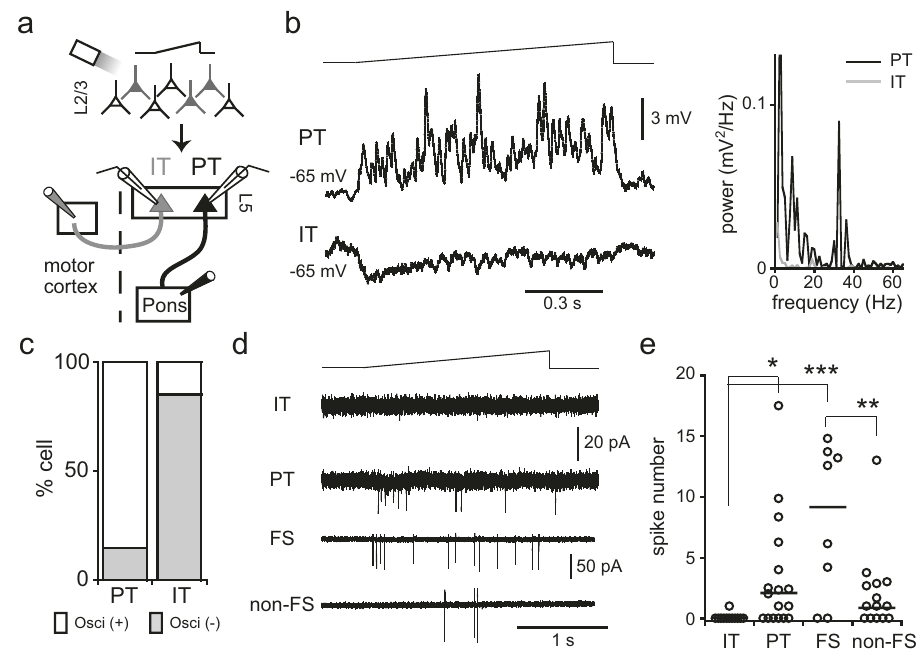
Fig. 3 Responses to L2/3 PC photostimulation in L5 cell subtypes. a Identi fi cation of L5 PC subtypes by retrograde fl uorescent tracer injections to contralateral cortex and ipsilateral pontine nuclei. b Dual recordings from identi fi ed PT and IT cells. Ramp-shaped light stimulation to L2/3 induced oscillations in PT cells, but not IT cells. Right graph, power spectra of membrane potentials of the PT and IT cells during stimulation. c Proportion of PT and IT cells that exhibited oscillatory activity, respectively (27 PT/IT cell-pairs). Oscillations were adopted when the ratio of peak power (25 – 40 Hz band) to averaged power (45 – 55 Hz band) >10, and peak power (25 – 40 Hz band) >0.5 mV 2 Hz − 1 . d Cell-attached recordings obtained from IT, PT, FS, and non-FS cells during ramp-shaped stimulation to L2/3 (upper trace). e Number of spikes induced in individual cell types during photostimulation. The horizontal bar indicates median number of spikes. Asterisk indicates signi fi cant difference (one-way ANOVA, F (3, 49) = 8.202, P = 0.00016; Bonferroni test, IT vs. PT, P = 0.0359, IT vs. FS, P = 0.0001, FS vs. non-FS, P =